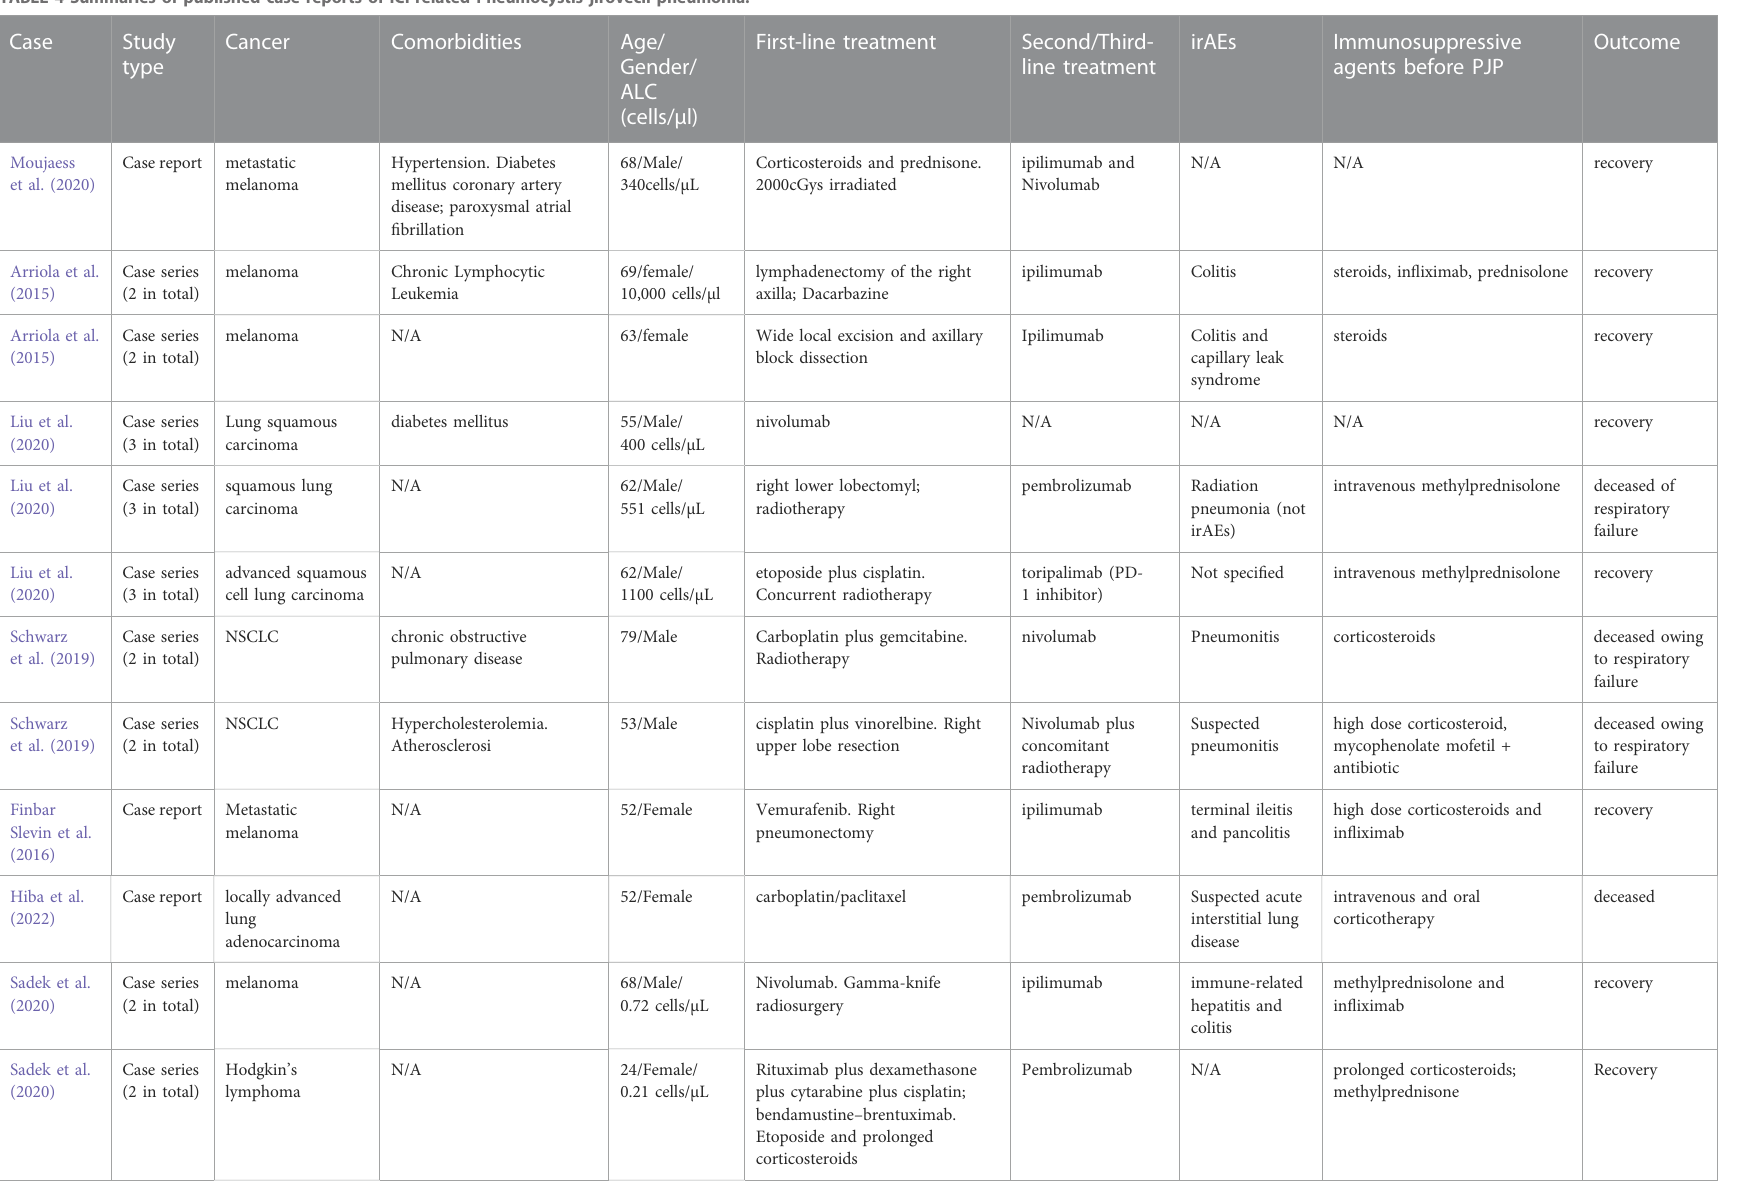
TABLE 4 Summaries of published case reports of ICI-related Pneumocystis jirovecii